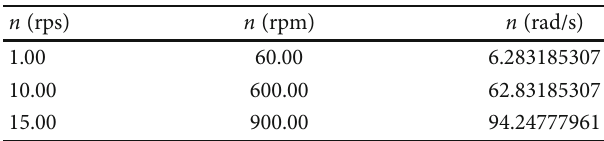
Table 11: Rotor rotational speed values to investigate a bollard pull